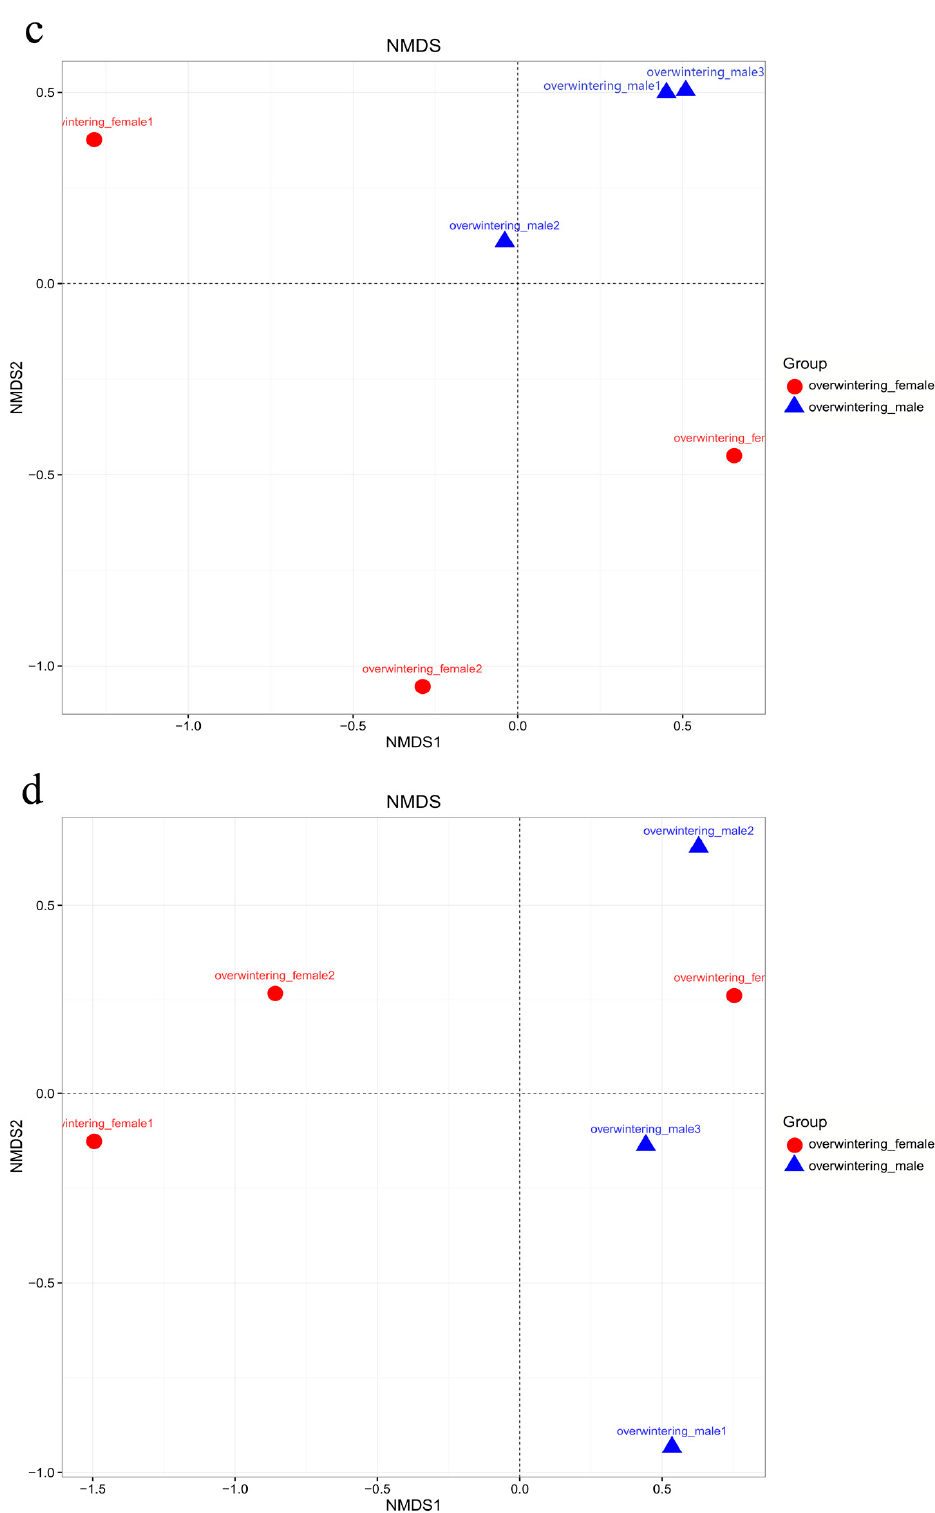
Figure 11. Nonmetric multidimensional scaling analysis of the Bray–Curtis dissimilarity index of the fungal community OTUs ( ≥ 97% identity) in different sexes of T. klimeschi based on Illumina sequencing of ITS genes. Adult females vs. adult males: ( a ) Unweighted; ( b ) Weighted; overwintering adult females vs. overwintering adult males: ( c ) Unweighted; ( d )